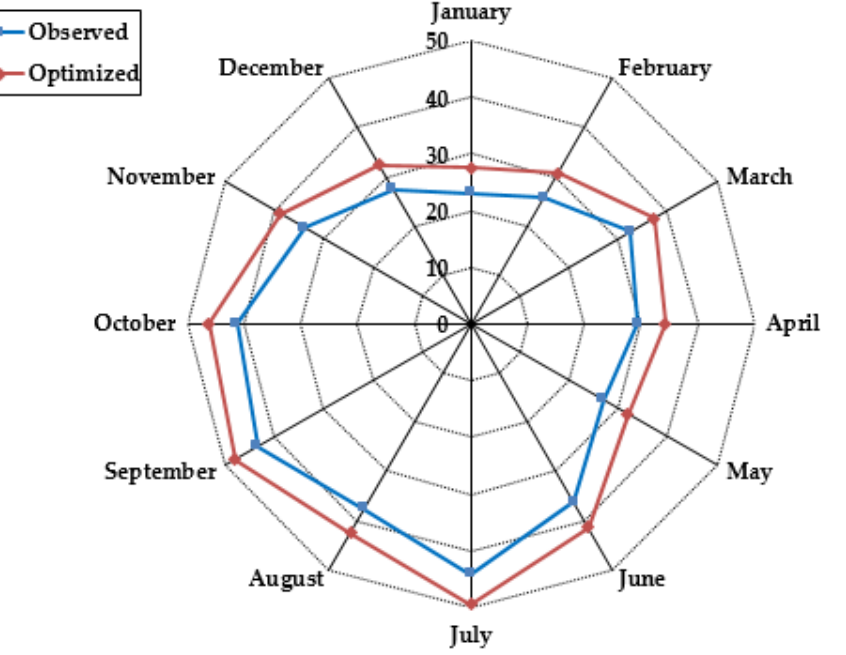
Figure 9. Average monthly current observed and optimized power generated of the Nashe reservoir.